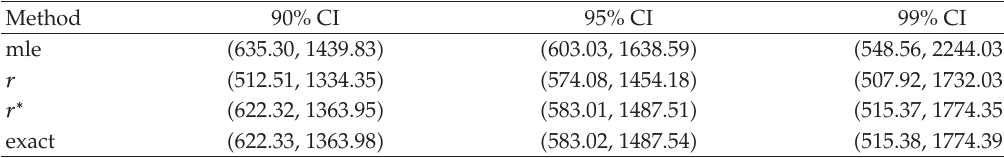
Table 2: Confidence intervals for σ .